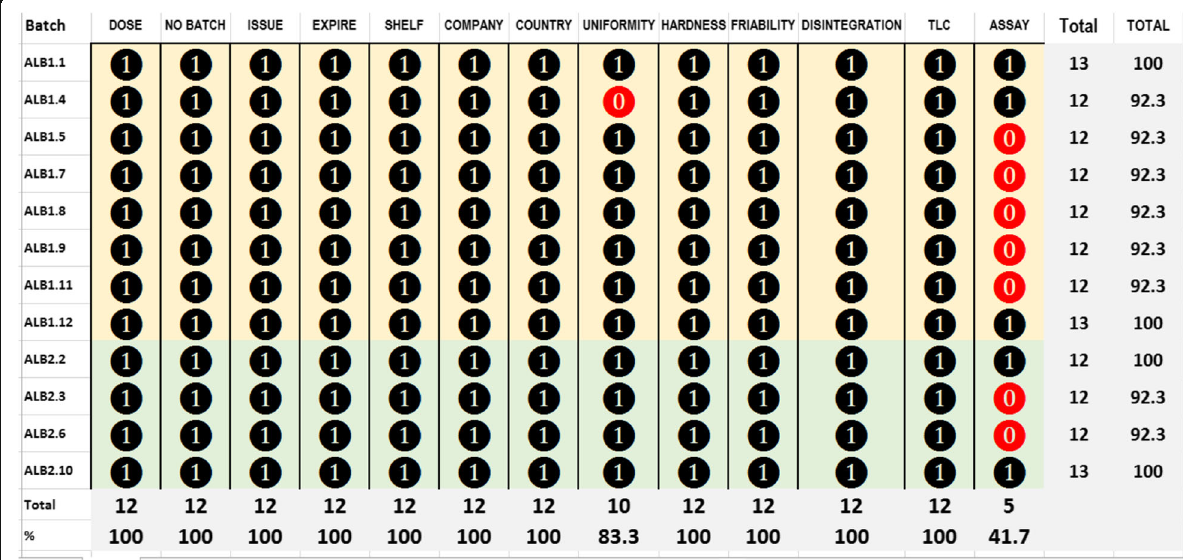
Fig. 3 Quality compliance scores of Artemether/Lumefantrine batches